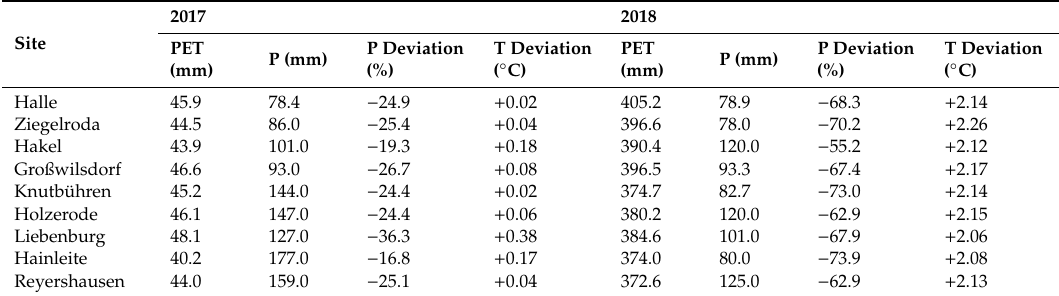
Table 2. PET, precipitation, and temperature in the three months prior to the sampling dates in 2017 and 2018. Given are the totals of potential evapotranspiration (PET) and precipitation (P), the deviation of P from the long-term mean (1991–2017) in percent, and the absolute deviation of the average